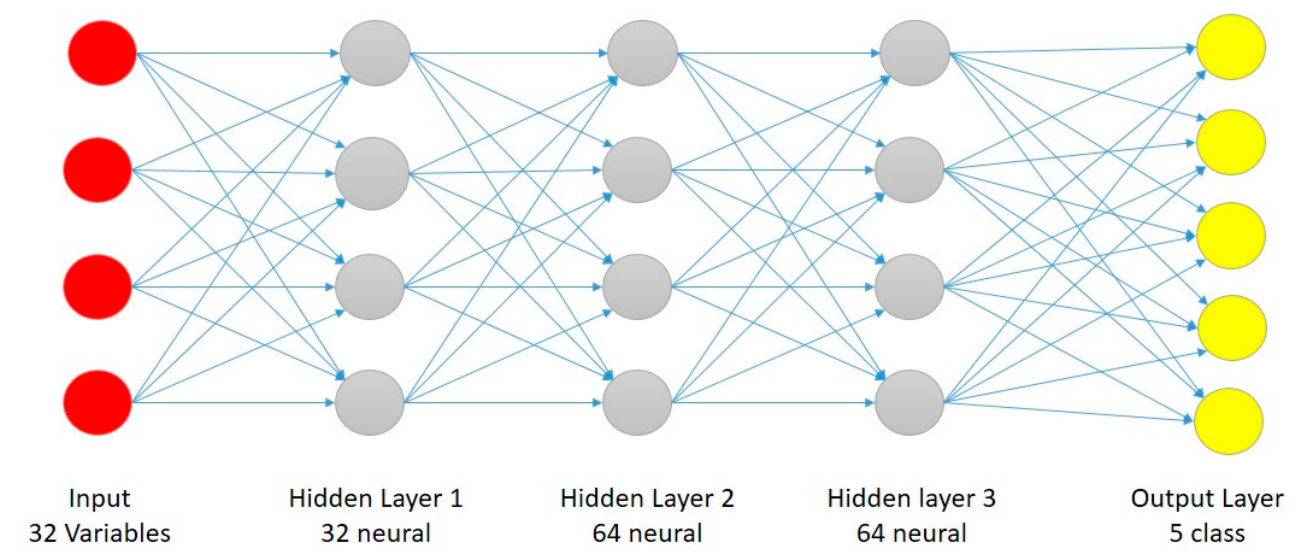
Figure 5. The structure of a three-layer multi-layer perceptron neural network with three hidden nodes and five output classes. Each hidden layer is directly connected to each component of the input layer and also to each component in the output layer.